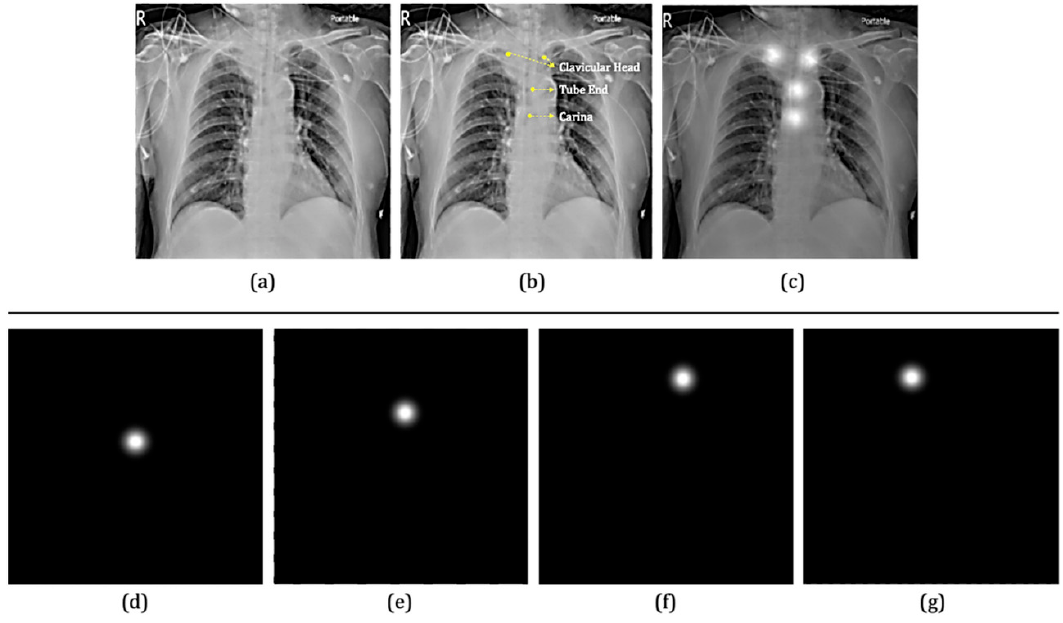
Figure 1. An example of the image and key points annotations. ( a ) The chest radiograph. ( b ) The coordinates (x, y) of left/right clavicular heads, tube end, and carina were marked by one physician. ( c ) The two-dimensional (2D) Gaussian function of these four key points is superimposed over the chest radiograph. ( d – g ) 2D Gaussian function of each key point, which serves as the ground truth for the model.